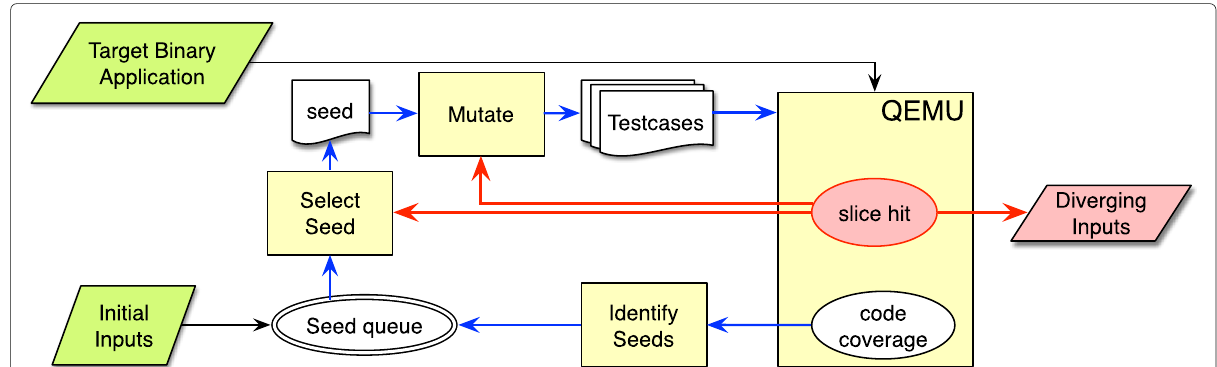
Fig. 6 Illustration of the fuzzer implemented by